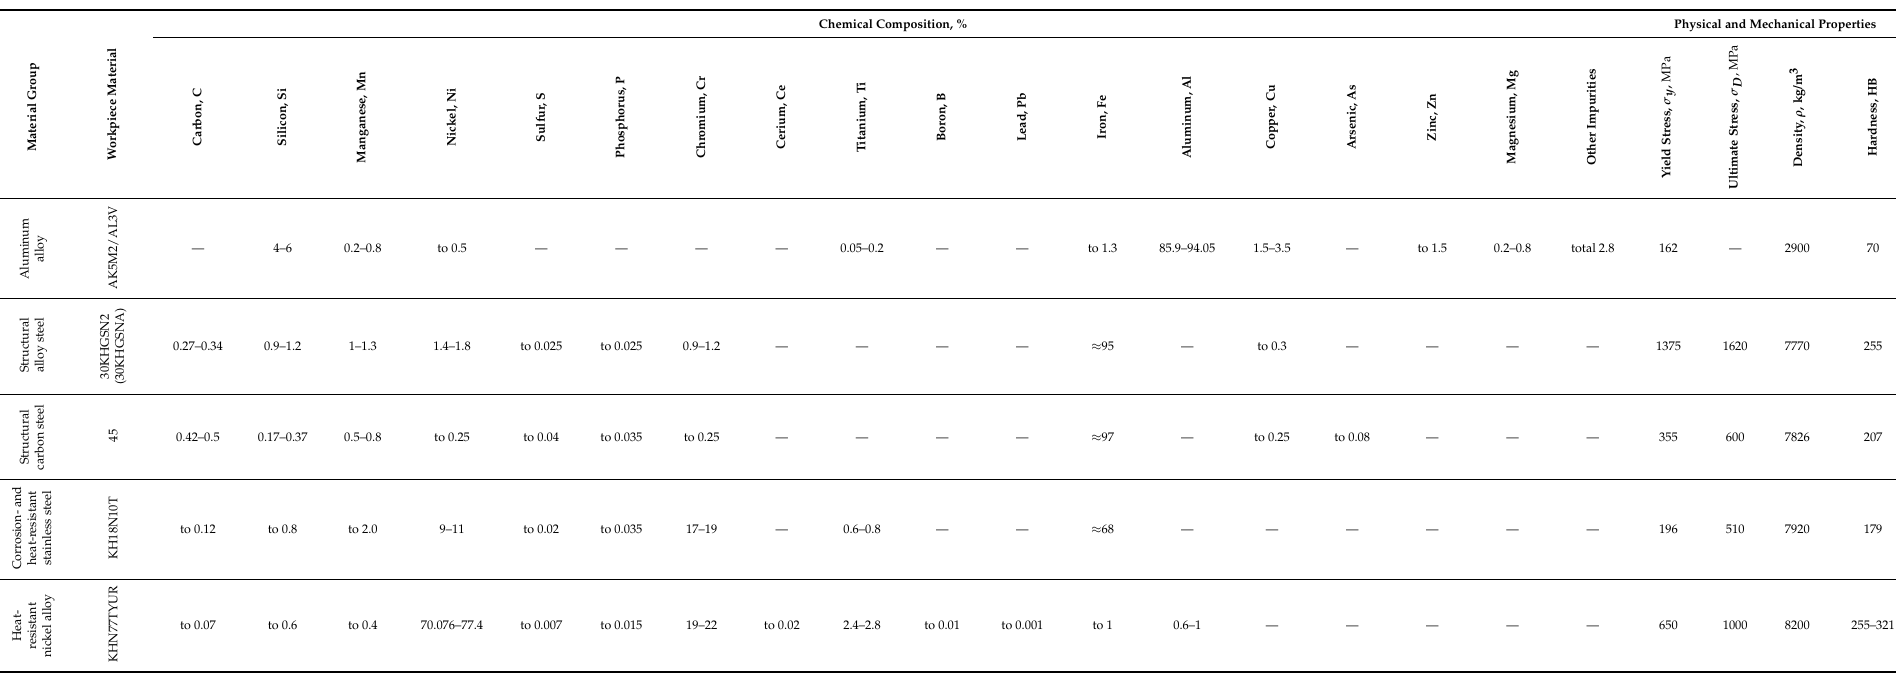
Table 3. The chemical compositions and physical and mechanical properties of materials. Adapted with permission from ref.